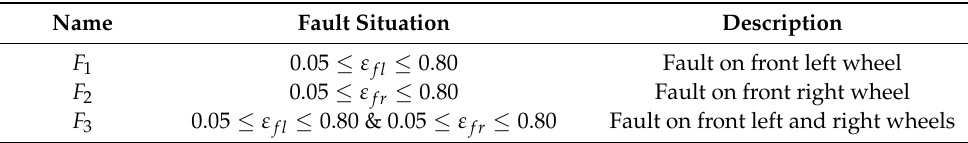
Table 2. Fault situations used during training.